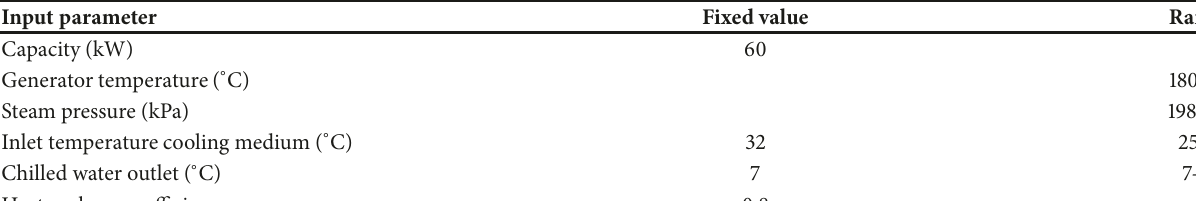
Table 2: Operating conditions assumed for the simulations.